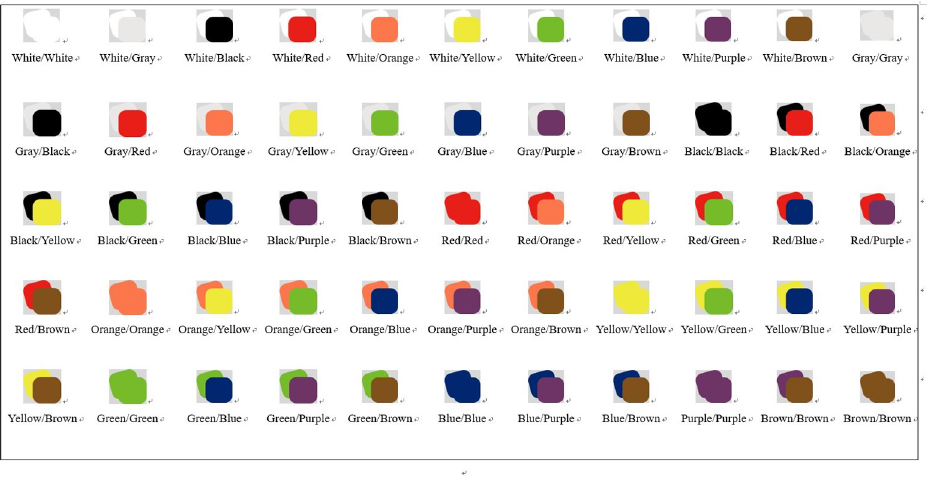
Fig 2. Two-color color scheme